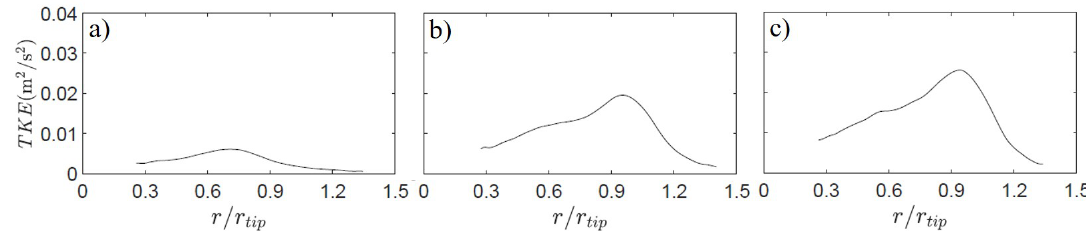
Figure 11. θ —averaged distributions of in-plane turbulence kinetic energy TKE of the different plates at ω = 90 rpm: ( a ) thin; ( b ) mediu; and ( c ) thick.